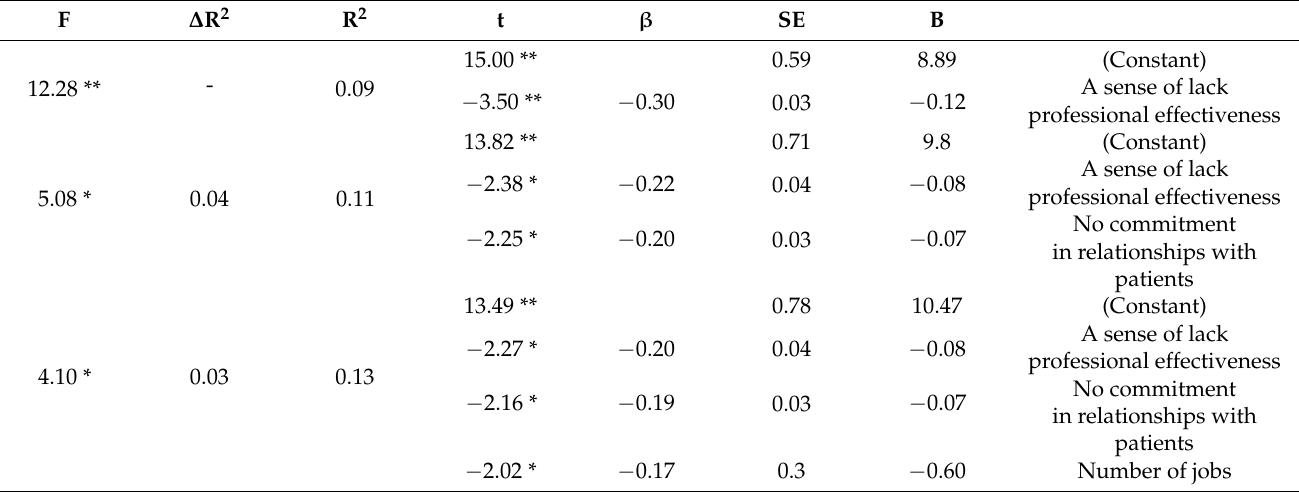
Table 6. Patient care quality assessment